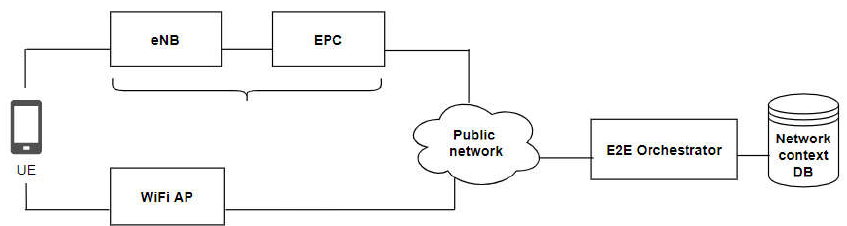
Figure 4. Testbed network architecture.